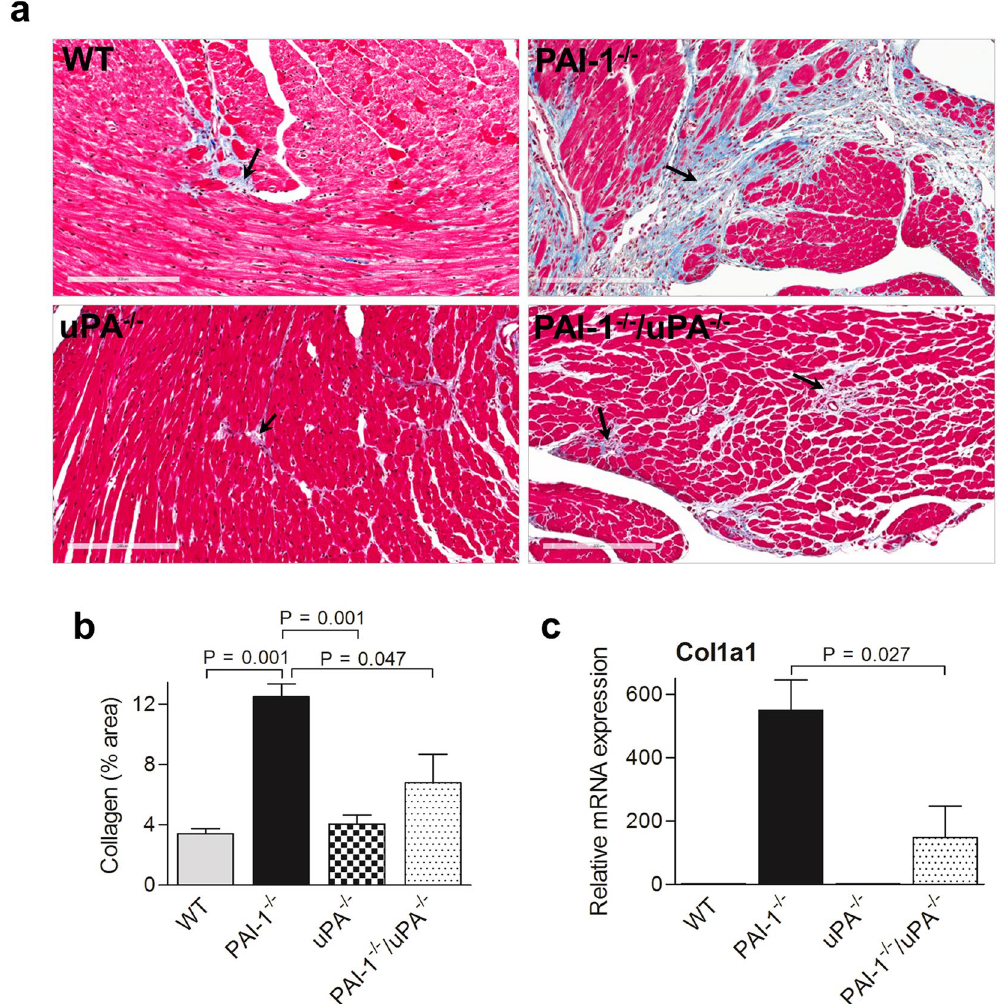
Figure 1. PAI-1 − / − /uPA − / − mice display reduced AngII-Ald-induced cardiac fibrosis. ( a ) Representative photomicrographs of Masson trichrome (collagen) stain (magnification: 200x). Extensive interstitial collagen deposition (blue staining) is indicated by black arrows. ( b ) Quantitative data showing the levels of collagen deposition in mouse hearts (n = 4–7 mice per group). ( c ) qRT-PCR analysis of cardiac Col1a1 gene expression (n = 4 mice per